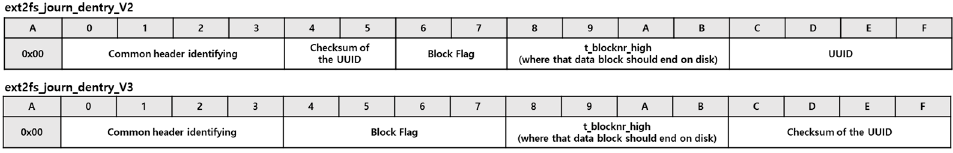
Figure 3. Journal descript block and journal block tag structure of Ext4 file system.